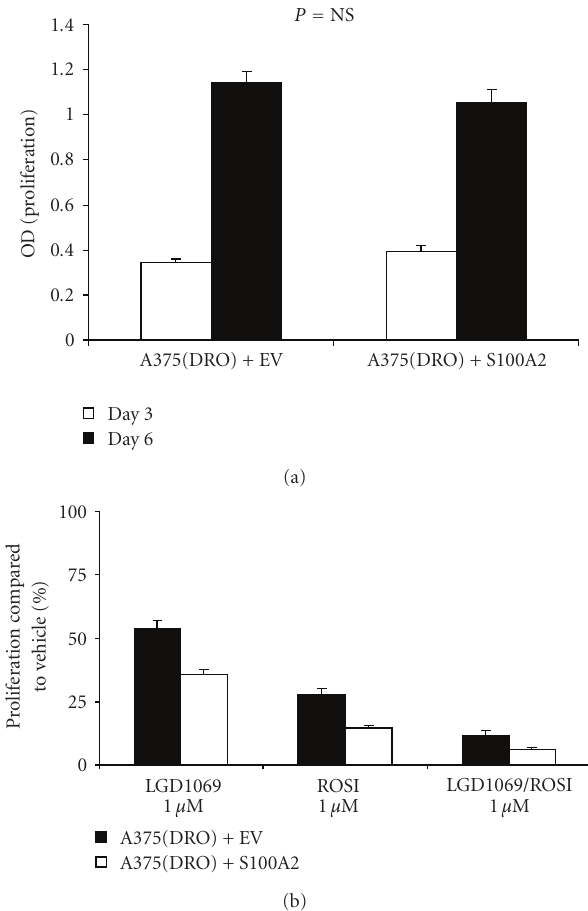
Figure 3: Proliferation of A375(DRO) cells overexpressing S100A2. Cells were grown in 2% fetal bovine serum RPMI in the presence of 1 μ mol/L of LGD1069, TZD, or the combination for 6 days. Cell growth was analyzed using a nonradioactive cell proliferation assay. Proliferation was compared directly between EV and S100A2 (a) and then to that of cells grown in volume equivalent vehicle (set at 100% which represents cell growth in control conditions) (b). Proliferation was significantly decreased in cells with S100A2 overexpression compared to EV for all treatment conditions compared to control. Columns mean; bars,